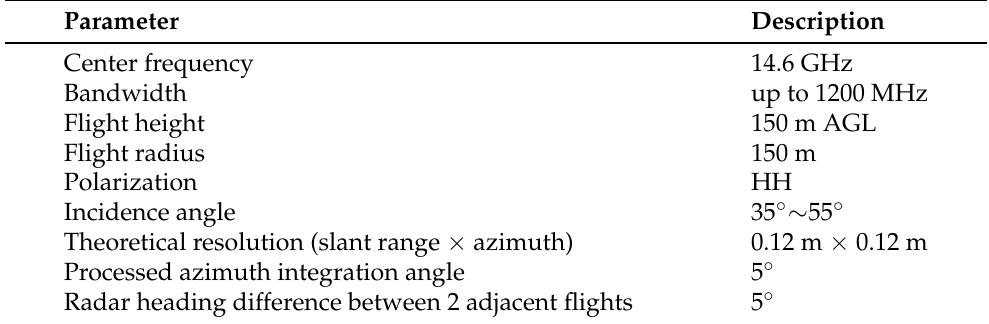
Table 1. Acquisition and processing parameters.